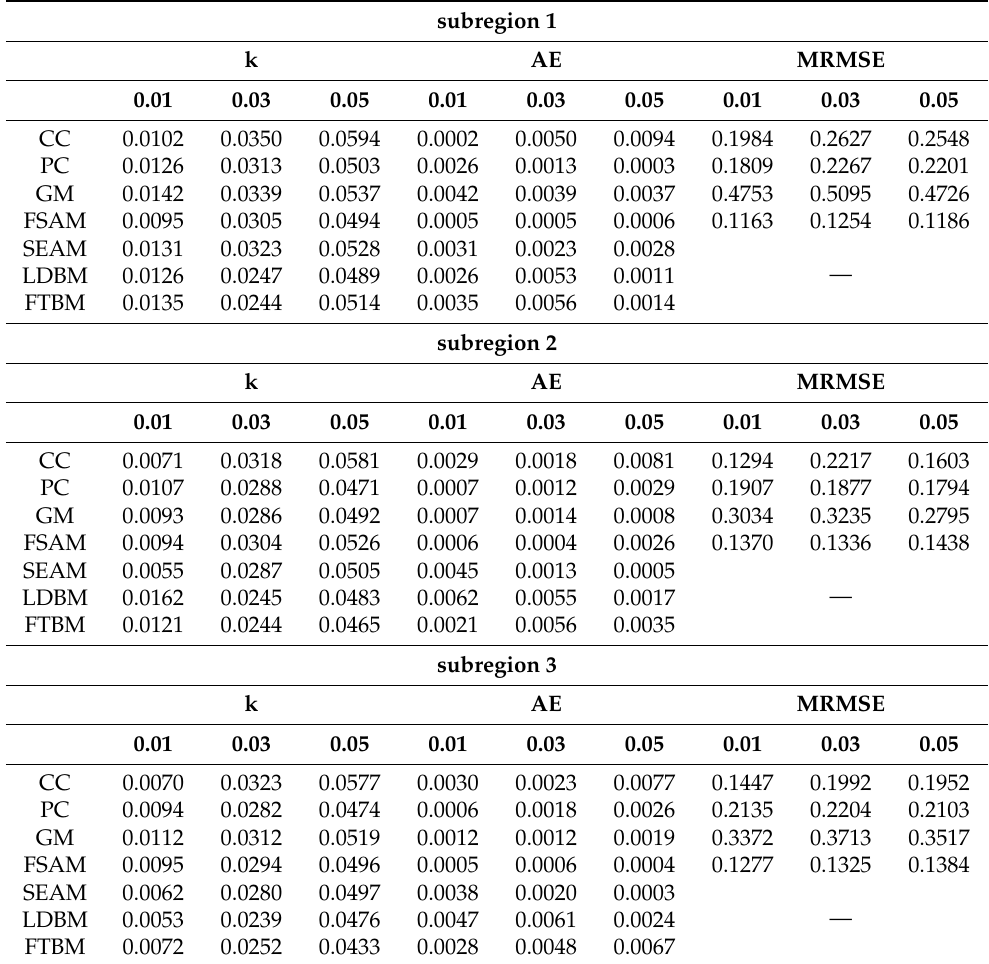
Table 4. The results of all test methods on subregion 1, subregion 2, and subregion 3 with spectral resolution of 6.4 nm.